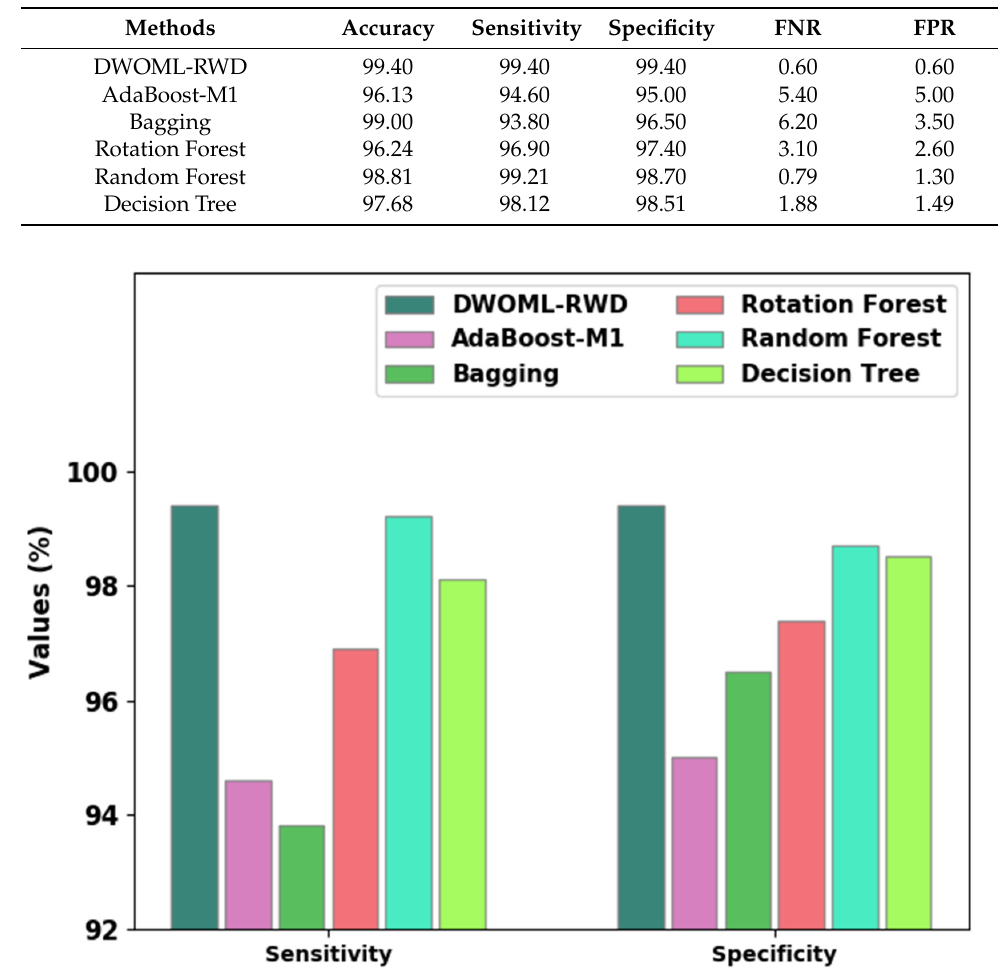
Figure 10. Sens y and Spec y analysis of DWOML-RWD approach with existing algorithms. Based Figure 10. 𝑆𝑒𝑛𝑠 (cid:3052) and 𝑆𝑝𝑒𝑐 (cid:3052) analysis of DWOML-RWD approach with existing algorithms. Based on spec y , the DWOML-RWD method gained enhanced spec y of 99.40%, whereas the Adaboost-M1, on 𝑠𝑝𝑒𝑐 (cid:3052) , the DWOML-RWD method gained enhanced 𝑠𝑝𝑒𝑐 (cid:3052) of 99.40%, whereas the Adaboost- bagging, ROF, RF, and DT algorithms resulted in lower spec y values of 95%, 96.50%, 97.40%, 98.70%, M1, bagging, ROF, RF, and DT algorithms resulted in lower 𝑠𝑝𝑒𝑐 (cid:3052) values of 95%, 96.50%, 97.40%, and 98.51%, 98.70%, and 98.51%, respectively.